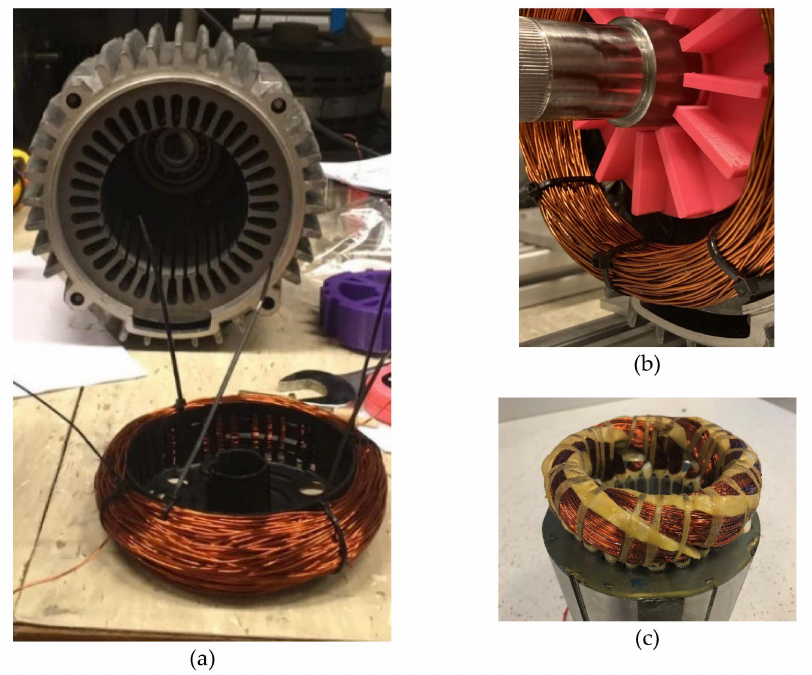
Figure 1. ( a ) Coil for representation of the end winding and the stator of 4 kW benchmark induction motor; ( b ) assembled experimental model; ( c ) end winding of an electrical